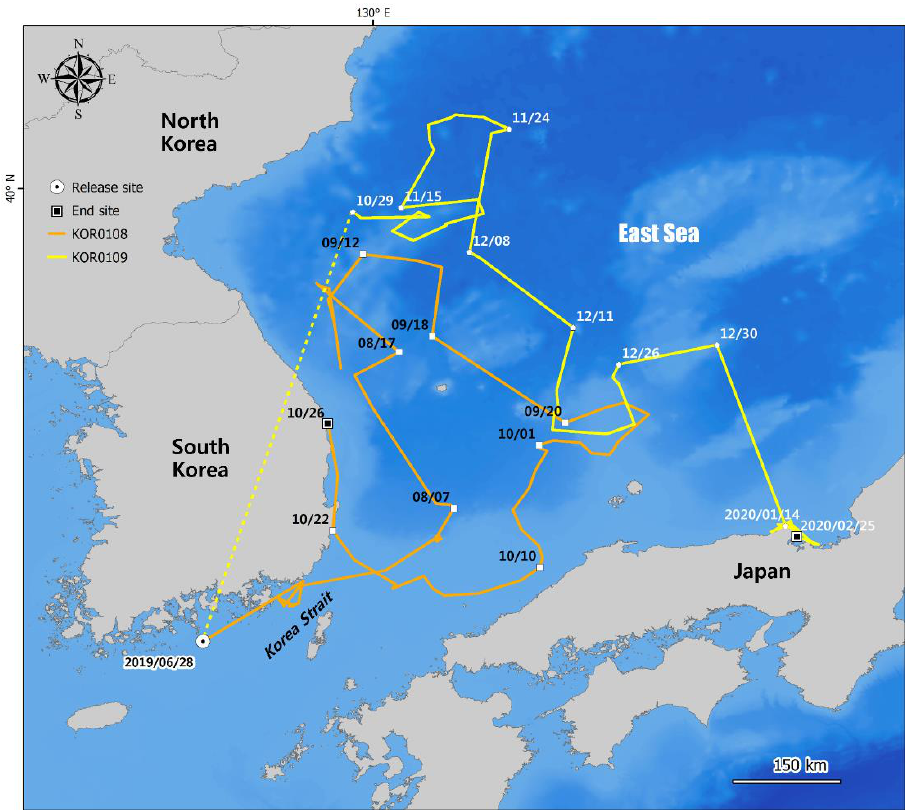
Figure 2. Travel routes of two satellite-tracked loggerhead turtles, KOR0108 and KOR0109. In the case of KOR0109, the dotted line between the release date and 10/29 (29 October) indicates a period when no tracking signal was received; the reasons for this are unknown.